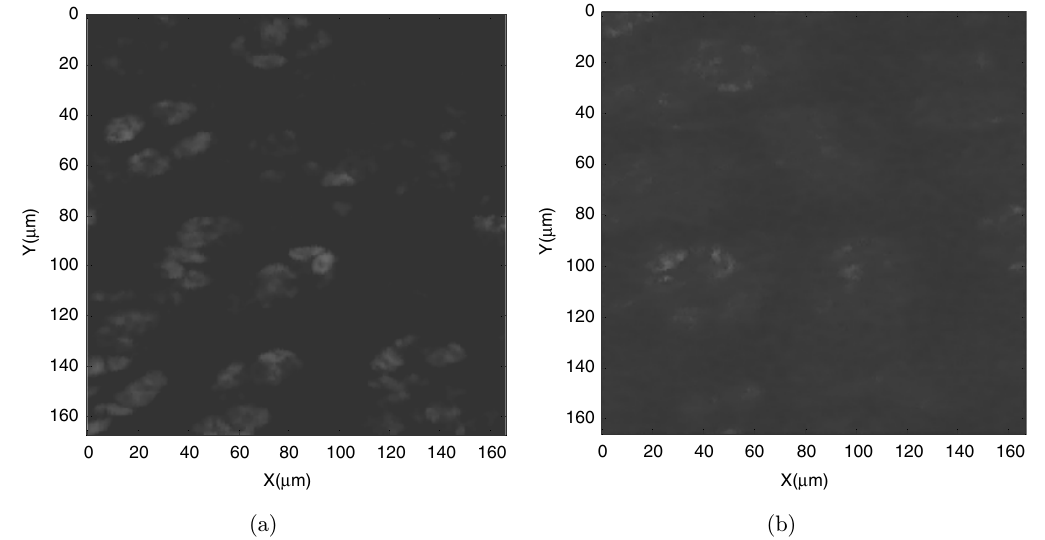
Fig. 15. FMM images obtained from (a) 500 microns and (b) 600 microns in depth.